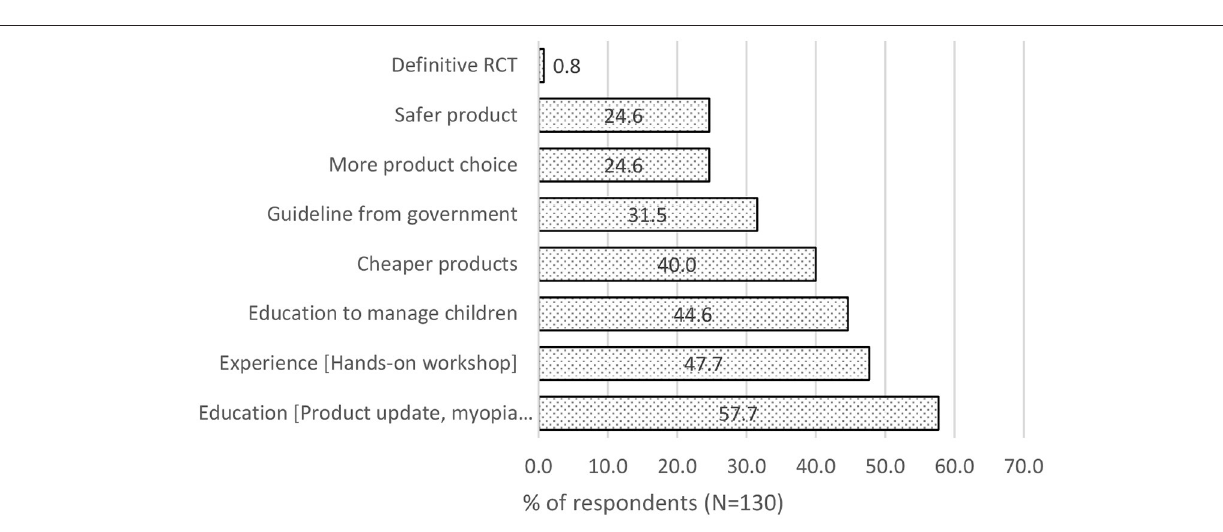
FIGURE 6 | Factors that will encourage Eye care practitioners to prescribe myopia control